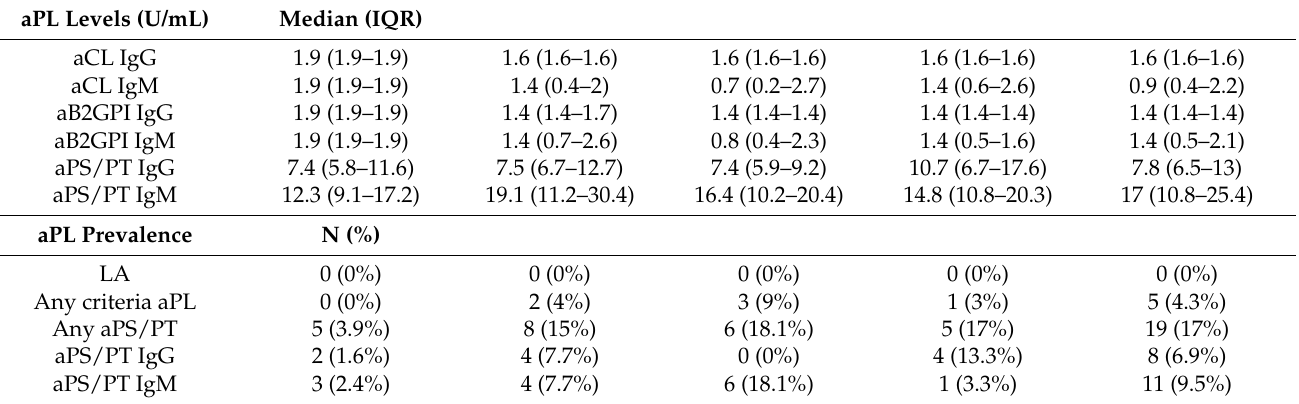
Table 2. Levels and prevalence of aPS/PT and criteria